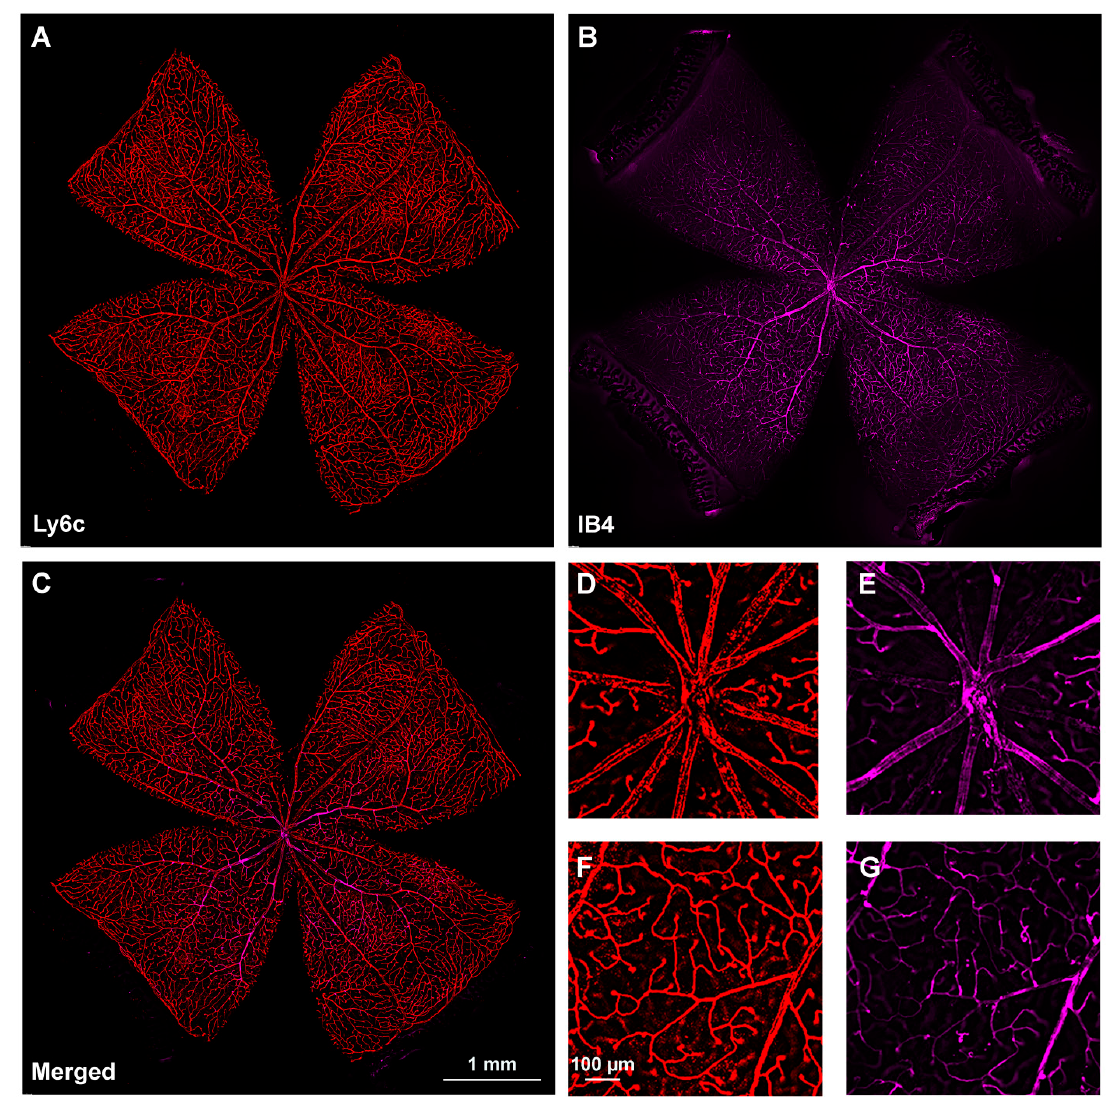
Figure 2. Comparison of Ly6c and IB4 vascular staining in the retina. ( A – C ) Photomontage of a representative intact retina showing Ly6C (( A ), red), IB4 (( B ), purple) and both signals ( C ) in the ganglion cell layer. ( D – G ) Magnifications from the central ( D , F ) and peripheral ( E , G ) retina are from the yellow squares in ( C ). Scale bar in ( C ) for ( A – C ) images, and in ( F ) for ( D – G ) panels.